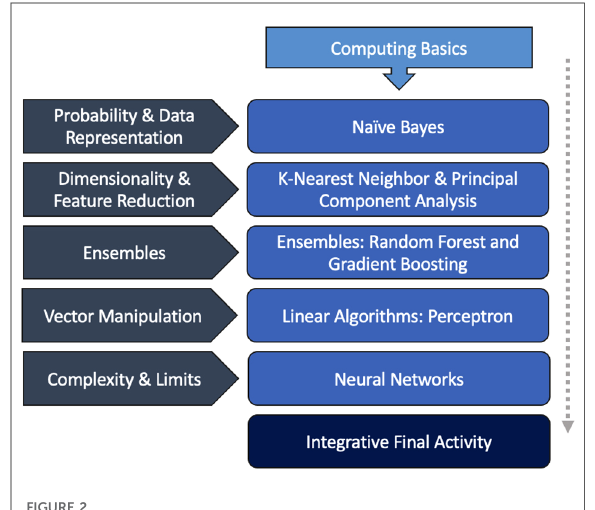
FIGURE 2 Intensive workshop AI-RADS curriculum. The outline of the